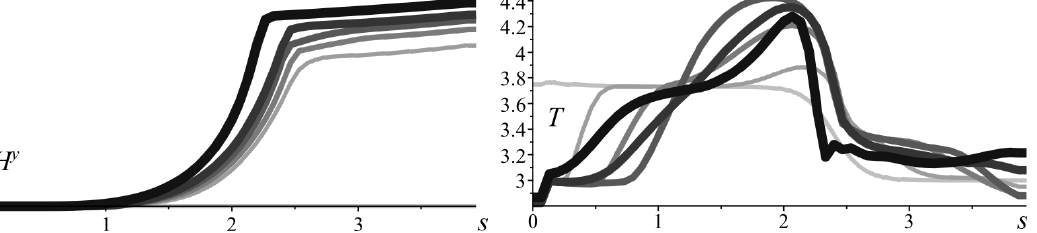
Figure 3. Evolution of the magnetic field H y and the temperature T for the second experiment.